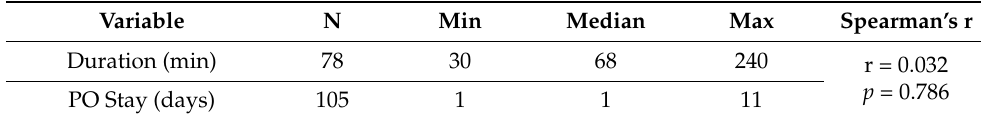
Table 3. Summary of surgery duration and postoperative hospital stay.